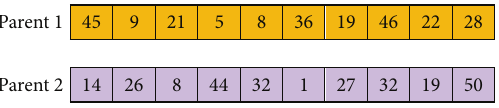
Figure 6: Two parent